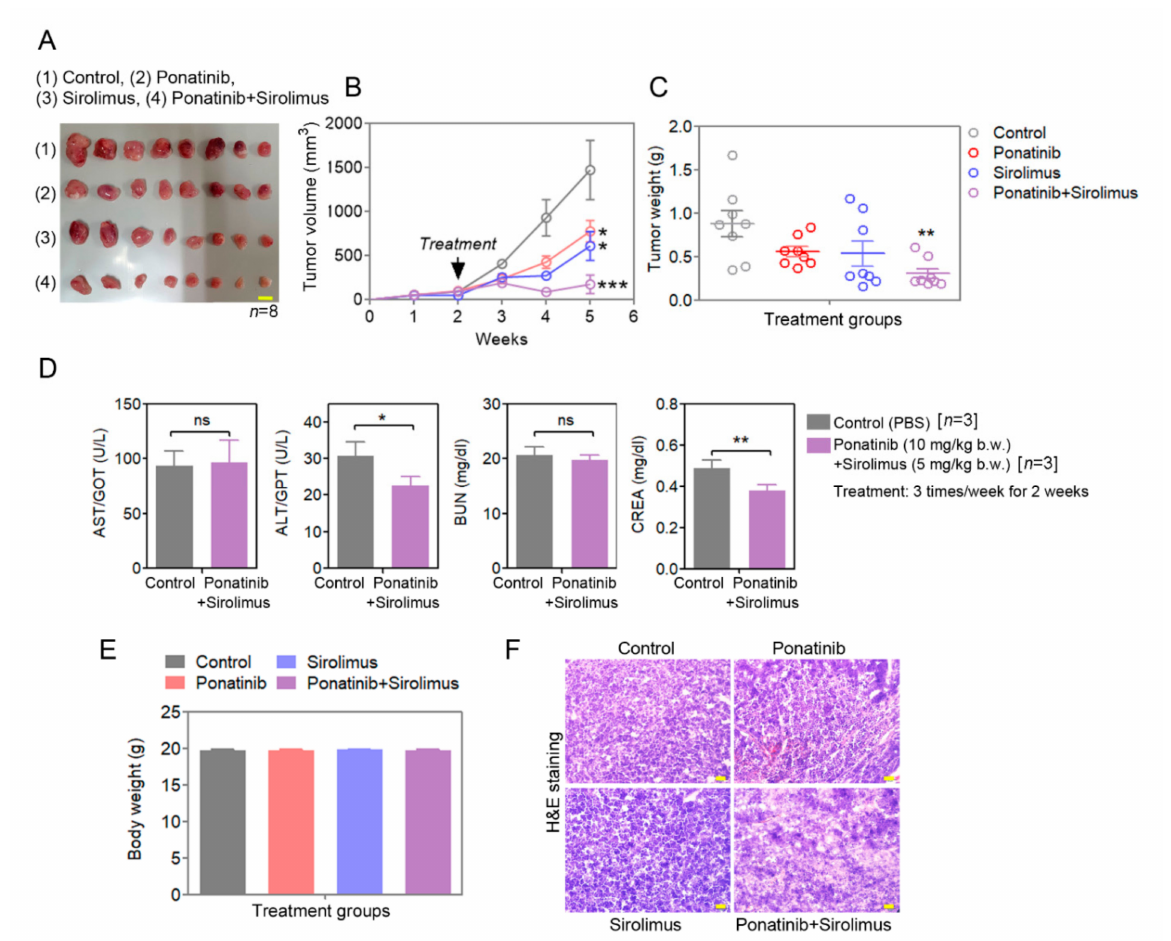
Figure 6. Ponatinib-and-sirolimus combination effectively reduces the multiple-myeloma tumor burden in athymic nude mouse. ( A ) RPMI8226 tumor images for different treatment groups. Scale bar corresponds to 1 cm (picture of n = 8 shown; there were 10 mice per arm). ( B ) Tumor volume was measured at different time points during treatments. The tumor volume was calculated and plotted as a curve, using GraphPad Prism 5 software. ( C ) The terminal tumor weight was measured and plotted by using GraphPad Prism 5 software. Achieved power analysis using G*Power 3.1.9.4 is shown in Table S6. ( D , E ) Different toxicity tests were performed for the ponatinib-and-sirolimus combination treatment group. Aspartate aminotransferase (AST), alanine aminotransferase (ALT), blood urea nitrogen (BUN), and creatinine (CREA) levels in the serum were measured biochemically. Terminal mouse body weight was measured. Data are presented as mean ± SEM; t -test: * p < 0.05, ** p < 0.01, and *** p < 0.001. ns: not significant. ( F ) H&E staining was performed on fixed tumor tissue samples; the scale bar is 20 µ m. Individual tumor sizes and their volumes are in Table